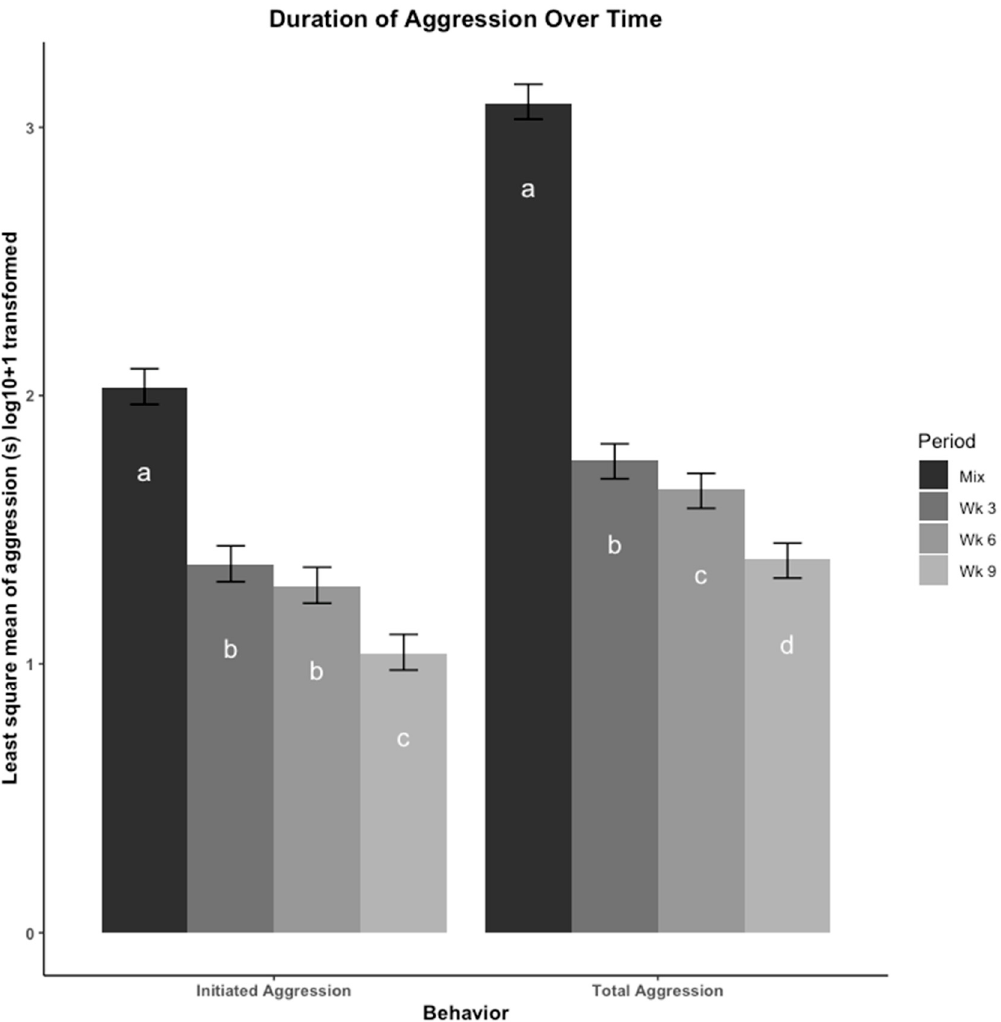
Figure 1. Aggressive behaviors were compared across four time points using least square means regression analysis. Aggressive behaviors were recorded using duration (seconds (s)) then log 10 + 1 transformed. The four time points are: immediately after mix, and 3, 6, 9 weeks (wk) after mix. Observations at 6 wk were made after pigs were moved to a new pen with their group. Aggression is presented as total duration (s) of aggression and total duration (s) of initiated aggression. Errors bars represent the 95% confidence interval of the least square means. a–d: Bars with different letters denote time periods that showed significantly different durations of that behavior ( p < 0.05, Tukey, HSD